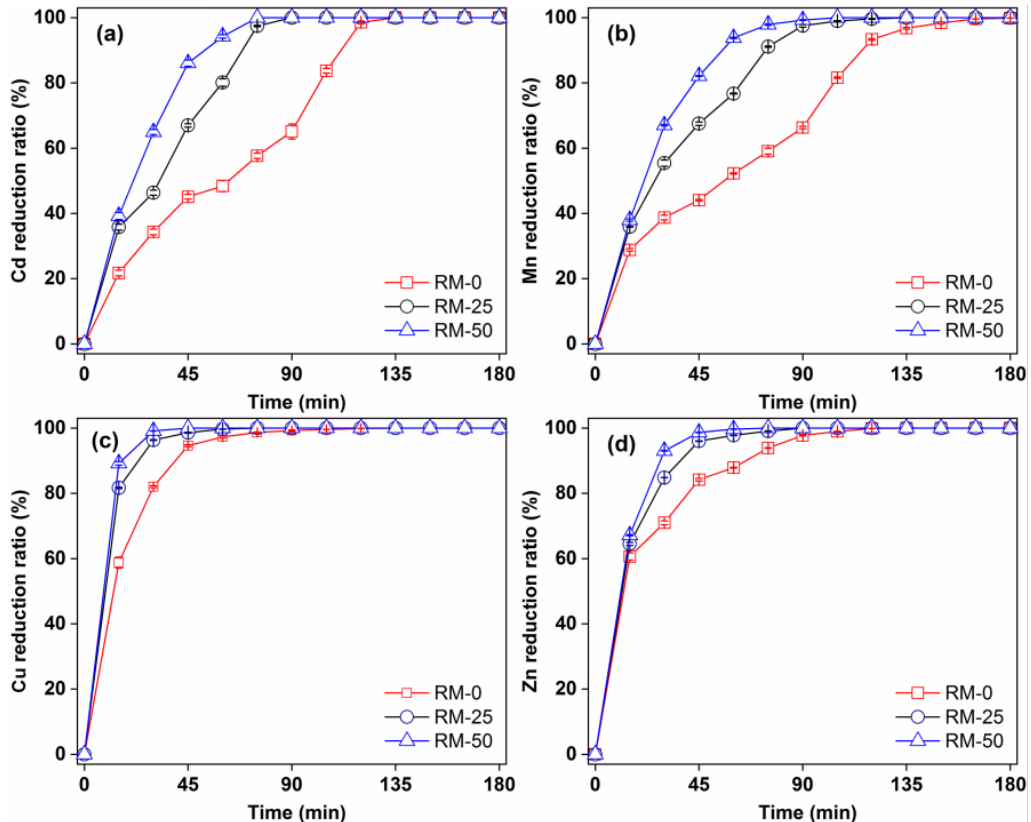
Figure 3. Time–dependent removal of ( a ) Cd, ( b ) Mn, ( c ) Cu and ( d ) Zn in RMPC with different red mud contents.